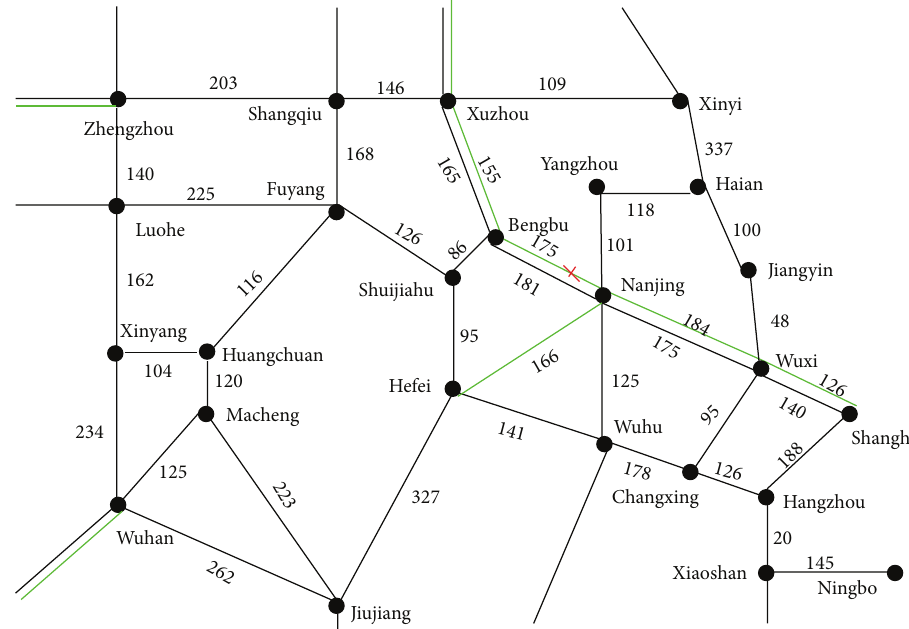
Figure 2: Railway network around the emergency place. Note: the green lines stand for high speed rails and the black lines stand for low speed rails.